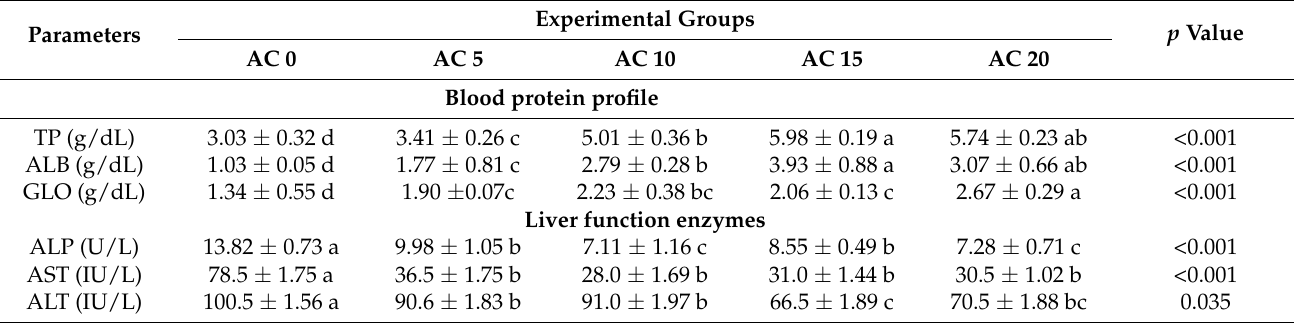
Table 4. Serum biochemical indices of Nile tilapia fed diets supplemented with graded, activated charcoal (AC) levels for 8